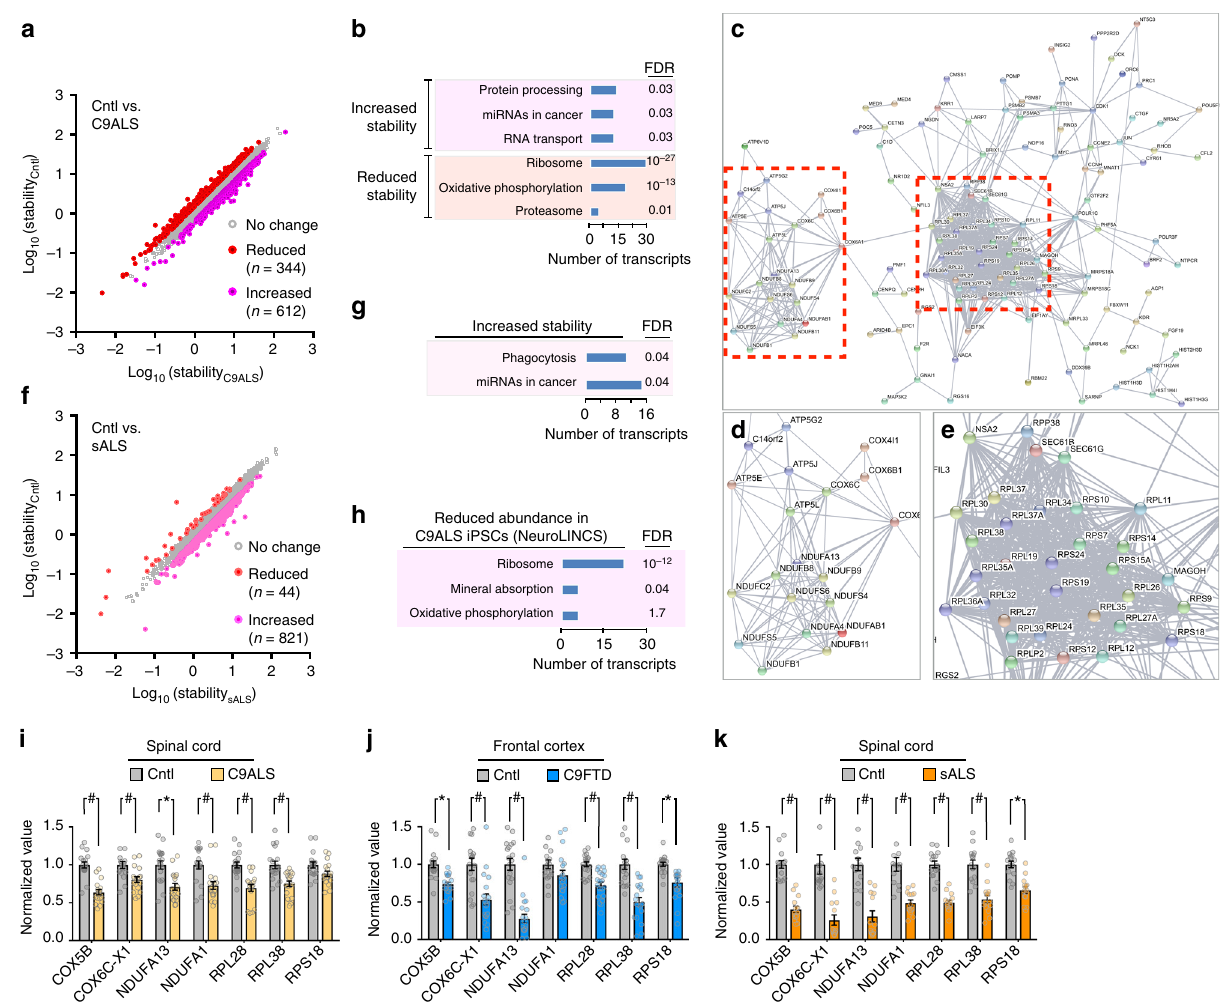
Fig. 3 Conserved patterns of RNA destabilization in C9ALS iPSCs. Scatter plot ( a ), gene ontology ( b ), and STRING analysis ( c ) for the 956 transcripts showing changes in stability ≥ 1.5-fold in C9ALS iPSCs, in comparison to control (Cntl) cells. Higher resolution views for boxed areas in c are shown in d and e . Scatter plot ( f ) and gene ontology ( g ) for 865 transcripts with altered stability ≥ 1.5-fold in sALS iPSCs, in comparison to control cells. h Gene ontology analysis of RNA transcripts showing ≥ 1.5-fold reduction in C9ALS iPSCs vs. controls, acquired from the NeuroLINCS database. FDR false discovery rate. Cell lines used for these experiments, performed in duplicate, are listed in Supplementary Table 1. i − k Quantitative (q)RT-PCR in patient postmortem tissue, showing reduced abundance of RNAs related to mitochondrial oxidative phosphorylation (COX6B, COX6C-X1, COX5B, NDUFA1, NDUFA13) and the ribosome (RPL28, RPL38, RPS18) in C9ALS spinal cord ( i ), C9FTD frontal cortex ( j ), and sALS spinal cord ( k ). Graphs in i − k depict mean ± standard error. * p < 0.05, # p < 0.01, two-way ANOVA with Sidak ’ s multiple comparison test. All data in i − k were assembled from ≥ 3 biological replicates. Supplementary Table 3 lists the number of samples in each condition and clinical characteristics for each